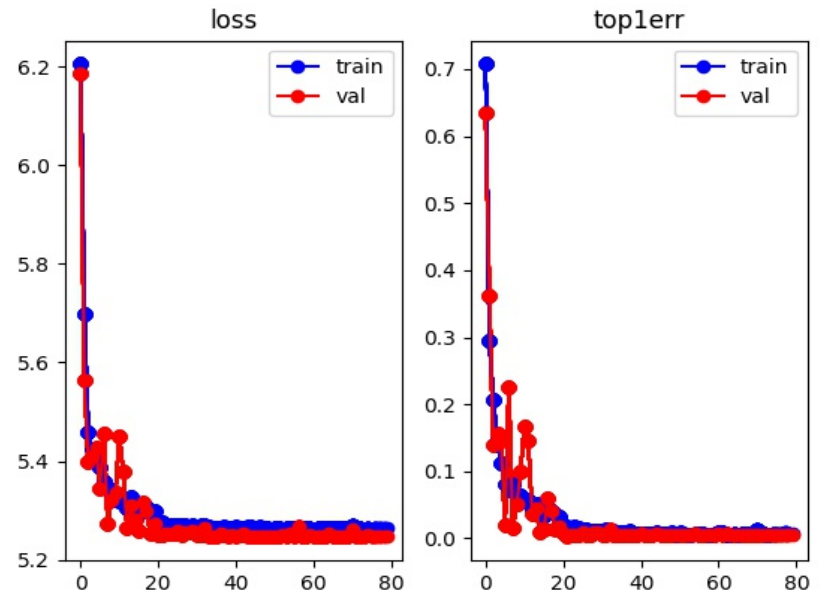
Figure 11. DeepSORT training loss function and TOP1 error rate.